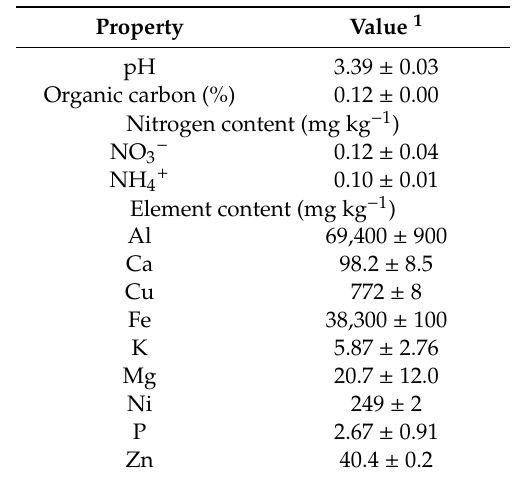
Table 2. Properties of the experimental soil used in this